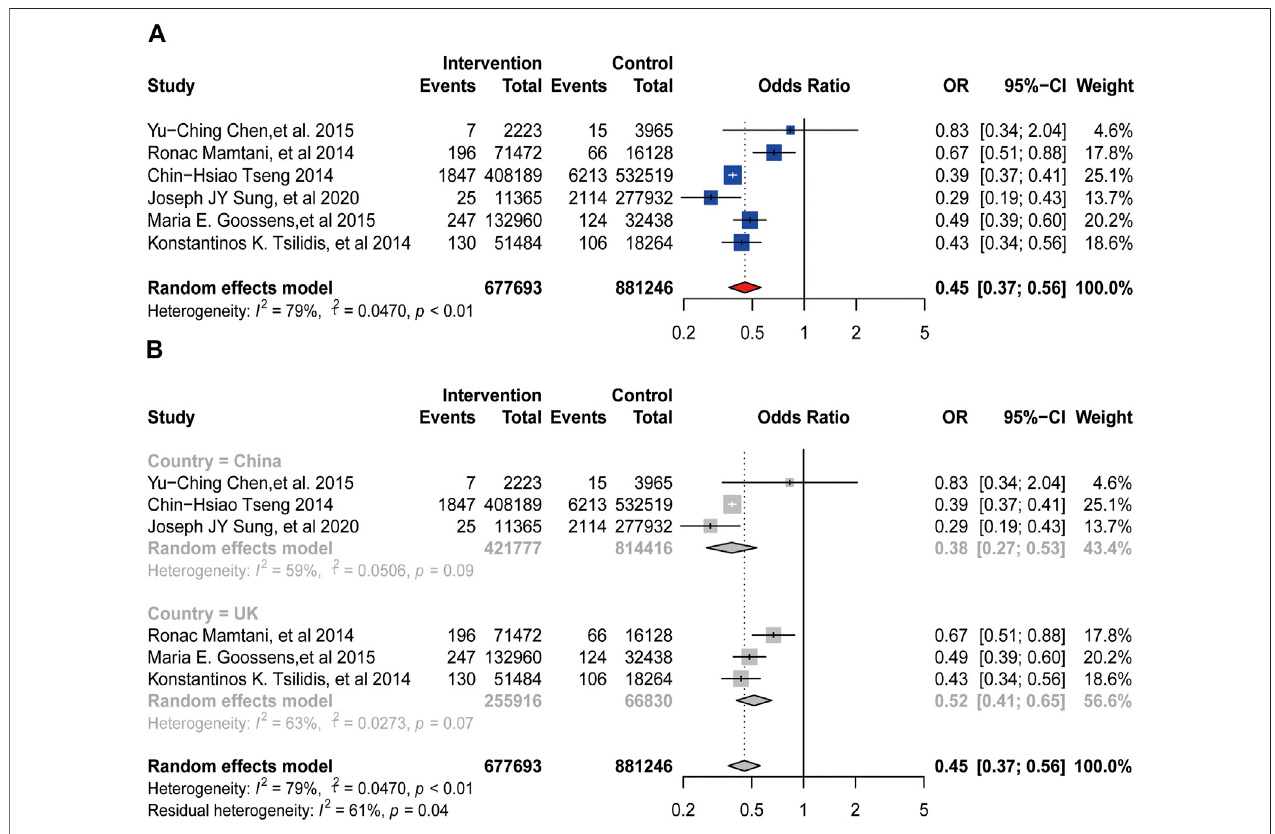
FIGURE 2 | Forest plot of odds ratio for incidence (A) Association between use of metformin and incidence of bladder cancer. (B) Subgroup analysis based on country.